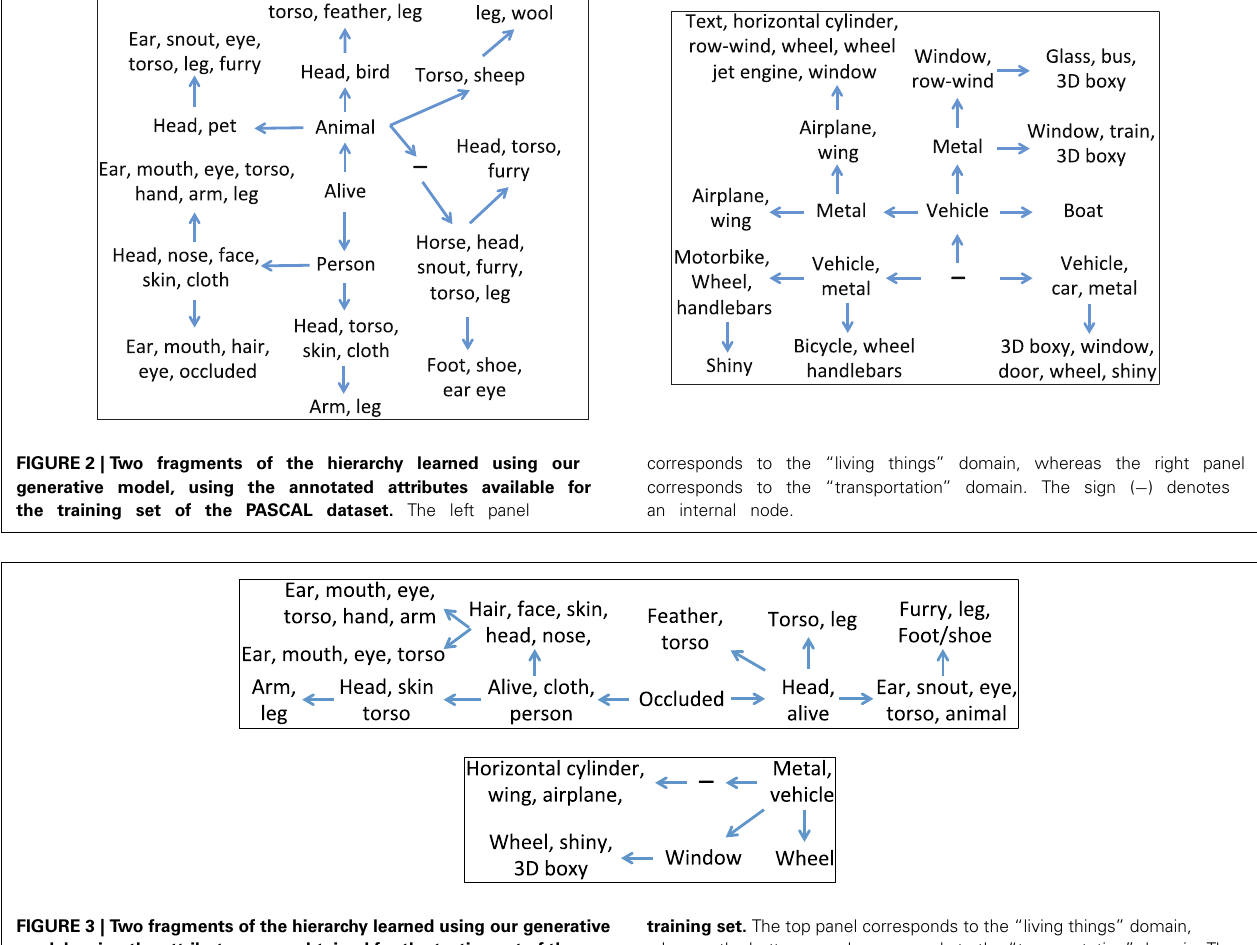
FIGURE 3 | Two fragments of the hierarchy learned using our generative model, using the attribute scores obtained for the testing set of the PASCAL dataset, when training the attribute detectors using the